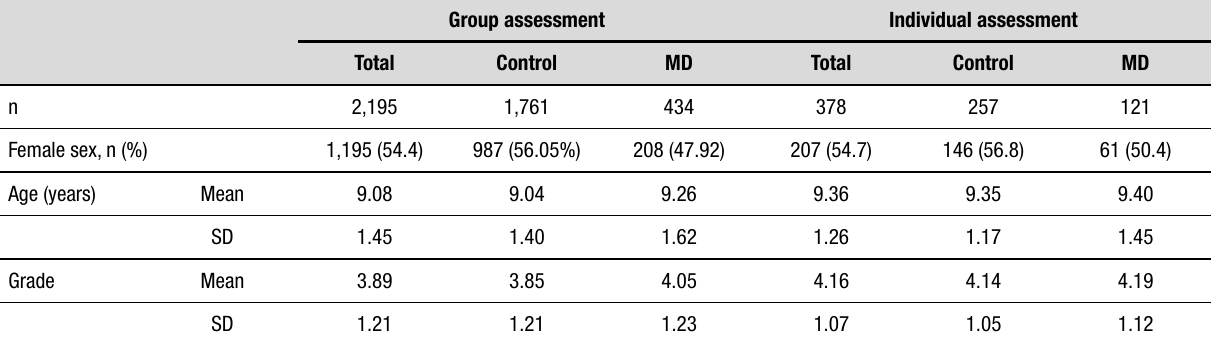
Table 1. Sociodemographic characteristics of